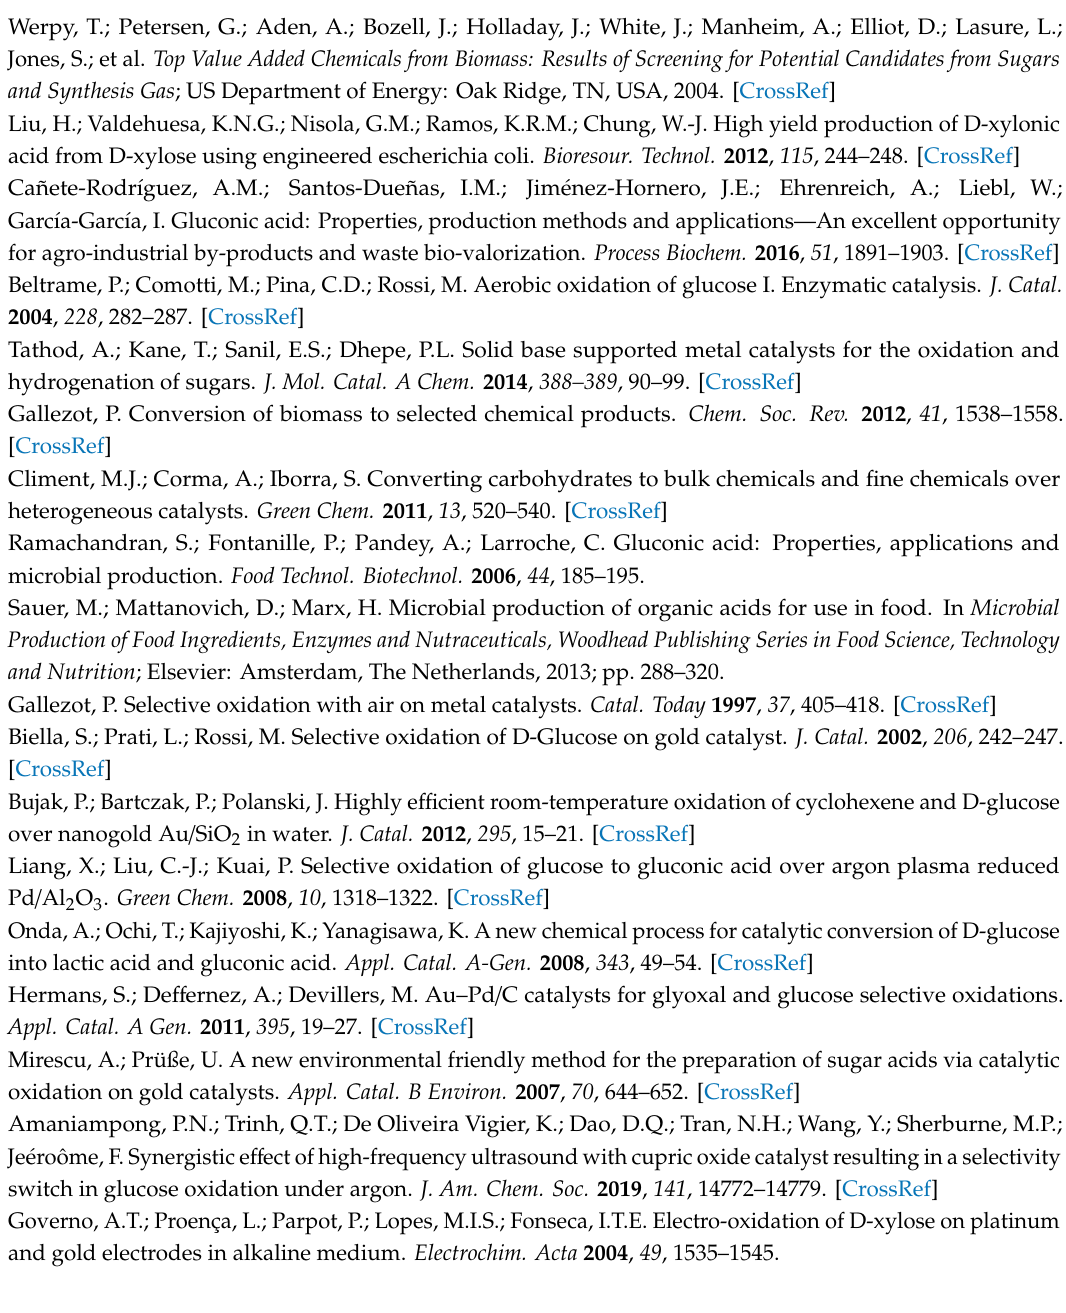
Chronoamperometry measurements, Figure S3: Picture of the electrochemical cell for chronoamperometry measurements and schematic representation of the electrolysis system designed for the chronoamperometry measurements, Section S4: Calculation of the energetic consumption to produce xylonate and